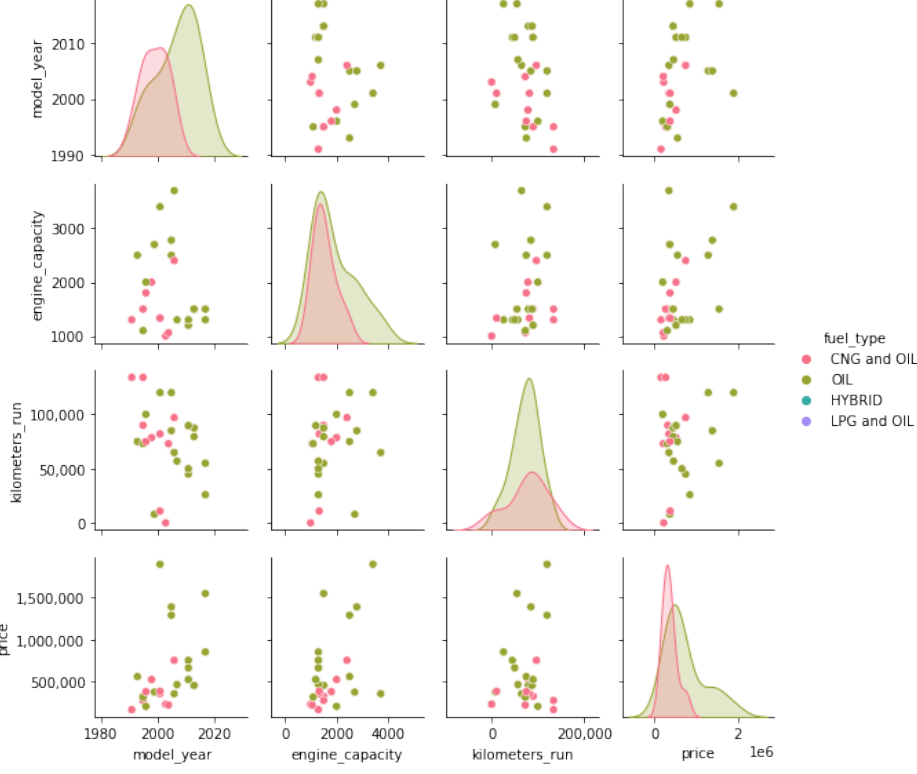
Figure 12. Pair plot of manual cars with different fuel_type